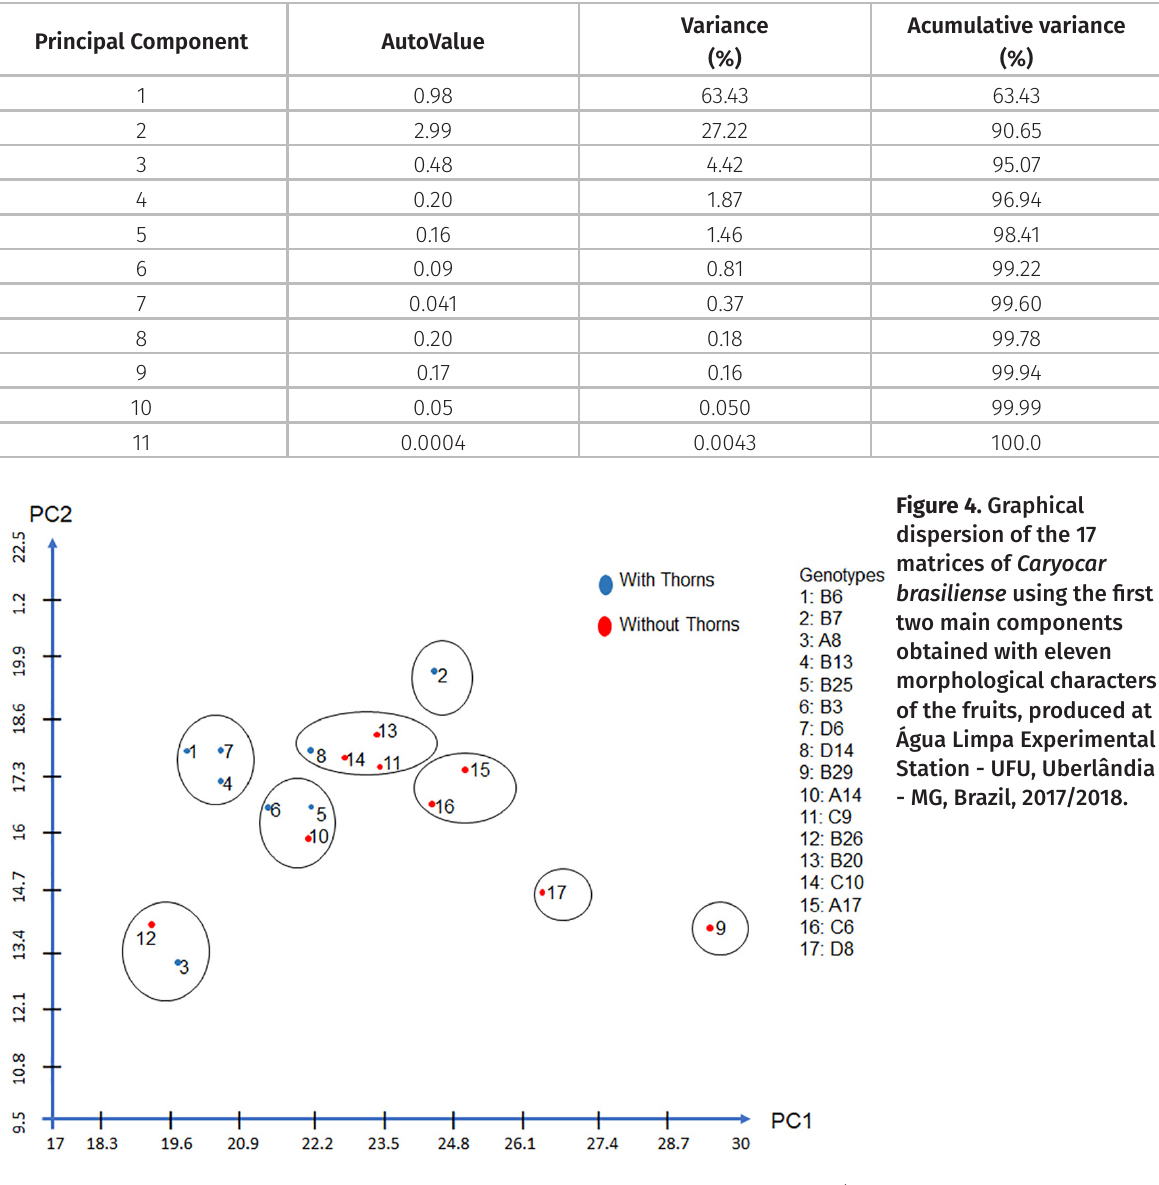
Table IV. Estimates of the eigenvalues associated to the main components and their percentage and cumulative variance of 11 morphological characters in C. brasiliense , produced at Água Limpa Experimental Station - UFU, Uberlândia - MG, Brazil, 2017/2018.